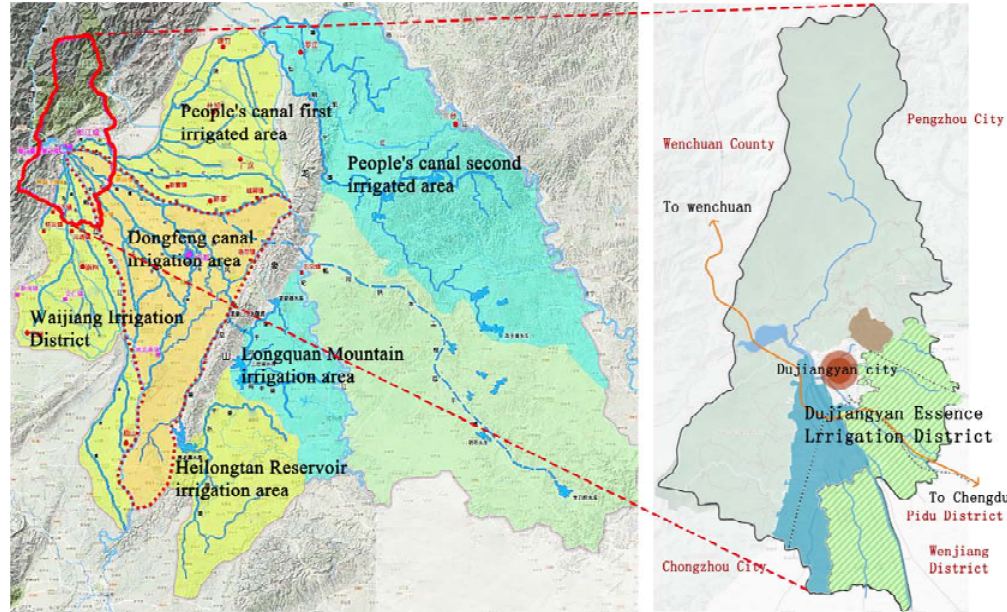
Figure 1. The geographical location of the Dujiangyan Irrigation District.